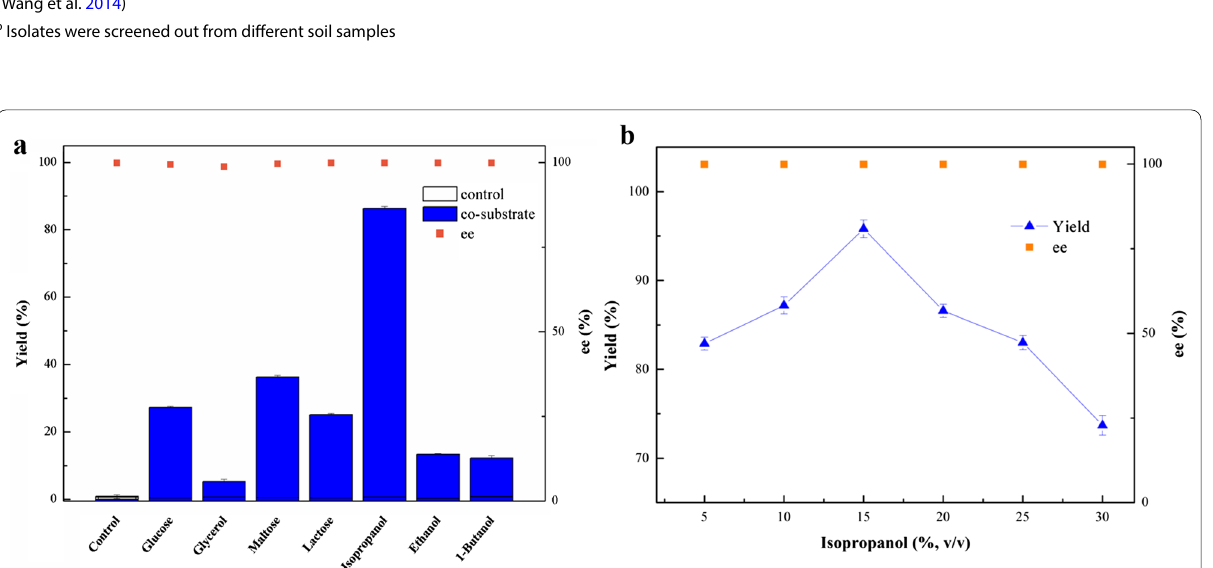
a Recombinant E. coli BL21(DE3)-pET28a( )-LXCAR-S154Y affording carbonyl reductase (LXCAR) gene from Leifsonia xyli HS0904 was acquired in our previous study + (Wang et al. 2014) b Isolates were screened out from different soil samples